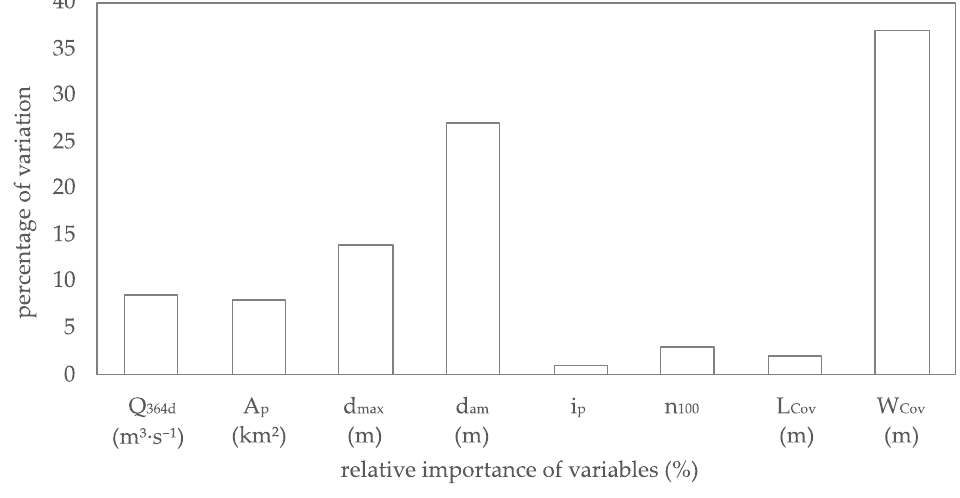
Figure 8. Relative importance of variables